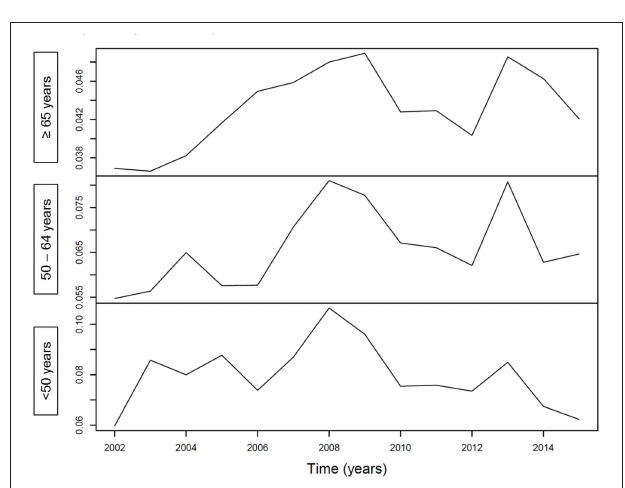
age was also significantly associated with in-hospital mortality and increased LOS in adults hospitalized with pneumonia